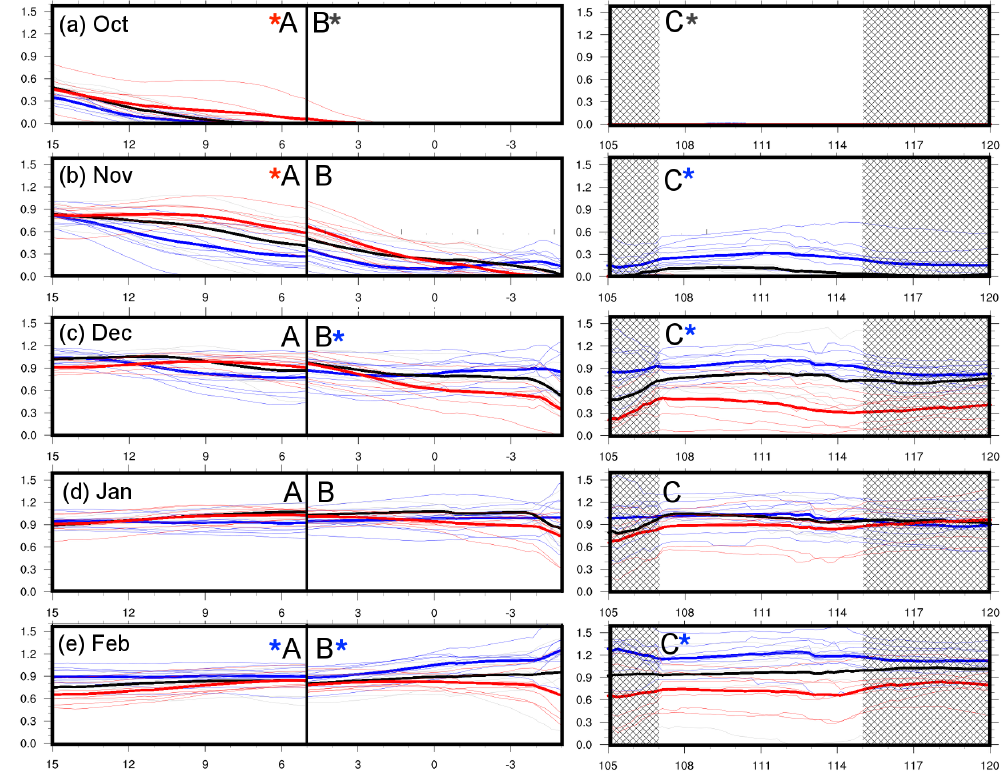
Figure 6. Fracsign calculated along the paths shown in Fig. 2 for (a–e) October to February. Values along path A and B are plotted against latitude ( ◦ N), while values along path C are plotted against longitude ( ◦ E). Thin grey, blue and red lines show values for individual phase- neutral, La Niña and El Niño years. Thick black, blue and red lines show mean values for the three phases. Red or blue asterisks next to the path label indicate whether the Niño or Niña values were significantly greater than the other (see Sect. 2.5), grey asterisks indicate testing was not done while no asterisks indicate the null hypothesis was not